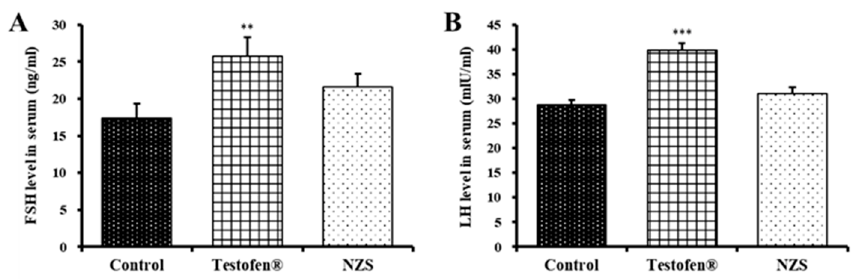
Figure 4. Comparative analysis of serum levels of follicle-stimulating hormone (FSH) ( A ) and luteinizing hormone (LH) ( B ) after NZS extract administration for four weeks. Data are expressed as means ± standard error (n = 5). Symbols of **, and *** denote significant differences compared to aged rat (control) at p < 0.01, and p < 0.001 levels,